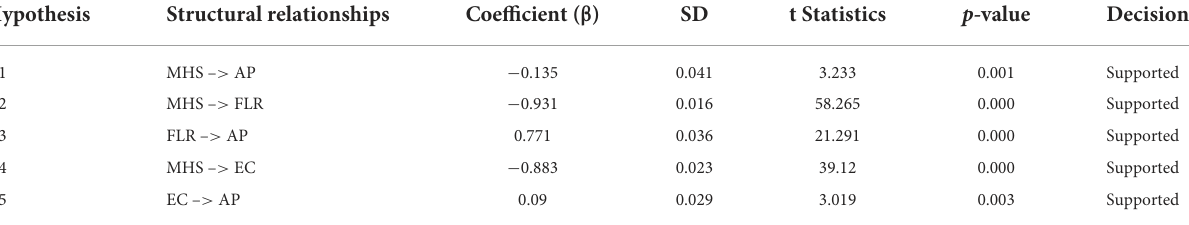
TABLE 5 Direct path effect